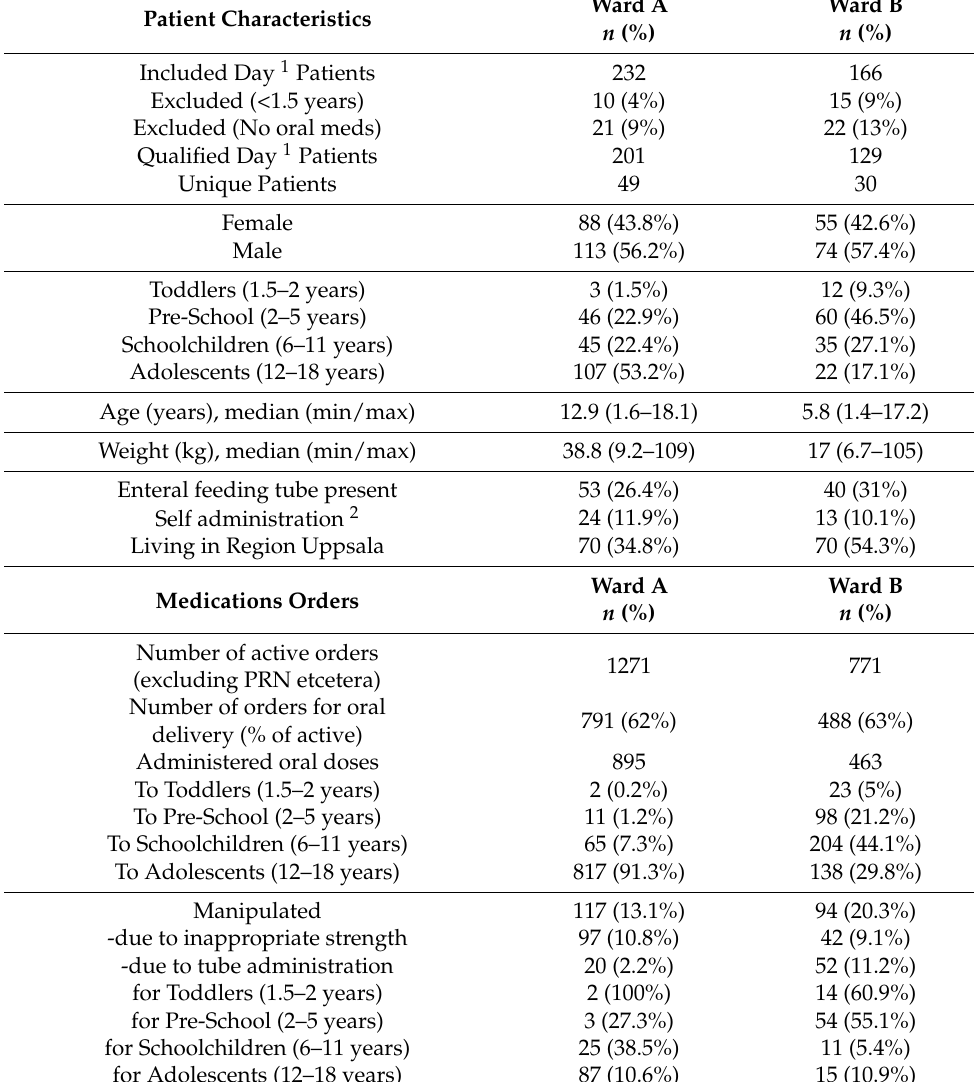
Table 1. Patient characteristics and prevalence of manipulations in paediatric oncology ward (A) and paediatric neurology ward